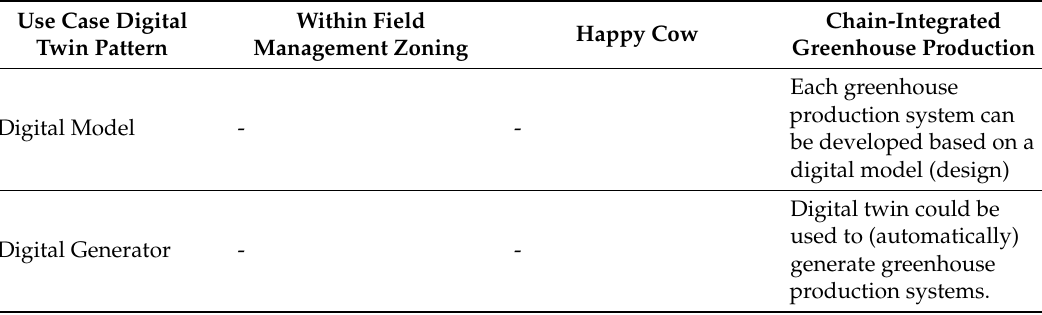
Table 5. Overview of the use cases and the identified digital twin